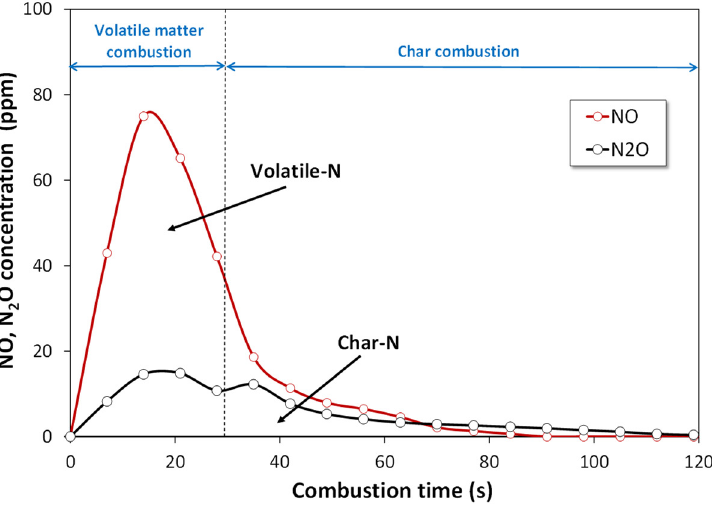
Figure 3. The instantaneous concentrations of NO and N 2 O during air-combustion of wheat straw. Oxidation of volatile-N was responsible for 75% of the total NO formed for Salix viminalis , 85% for Scots pine and 65% for coal (Figure 4). Volatile-N contributed 48% to the total N 2 O formed during combustion of Salix viminalis and 32% during combustion of Scots pine and